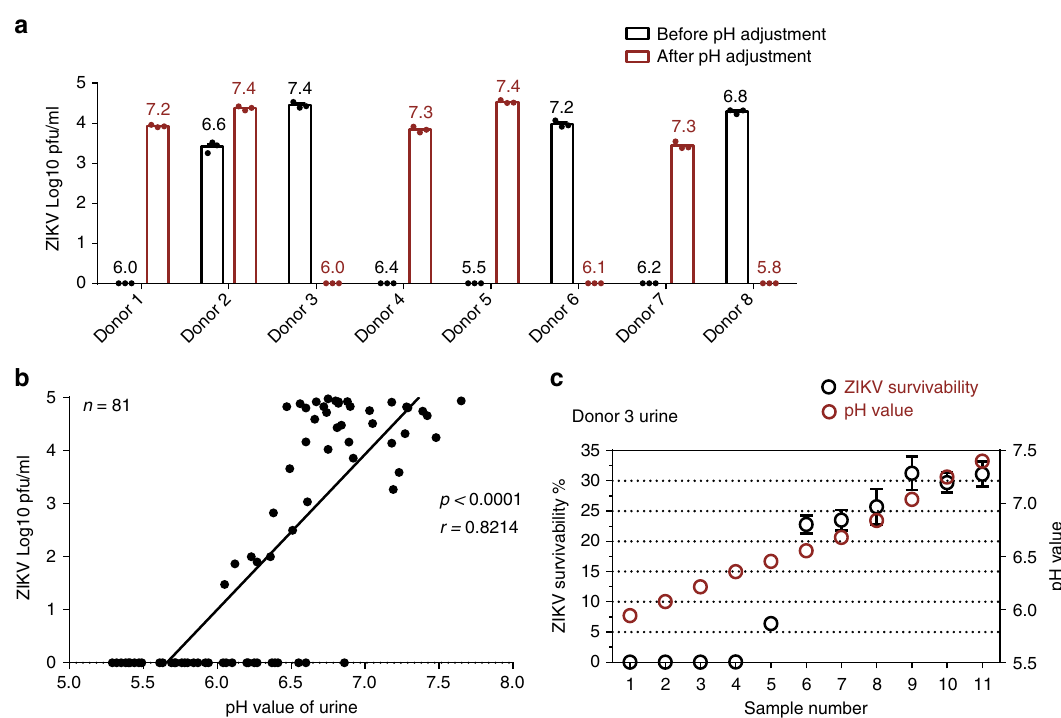
Fig. 4 Correlation between Zika virus (ZIKV) survivability and the pH value of human urine. a Adjustment of pH value regulated ZIKV survivability in human urine. The pH values of human urine samples were adjusted by either NaOH or HCl. The pH value is showed at the top of each column. n = 3 biologically independent samples. Data are presented as the mean ± SEM. b ZIKV survivability in human urine correlates with the pH value of urine. One dot represents one human urine sample. Data were analyzed by linear regression with correlation coef fi cients ( r ) and signi fi cance ( p ). n represents the number of human urine samples. The information for the urine samples is summarized in Supplementary Table 4. c Determination of the correlation between ZIKV survivability and the pH value in human urine. The urine samples from Donor 3 with gradient pH values were incubated with ZIKV supernatant. The percentage of ZIKV survivability was de fi ned as the ratio of the pfu value at 4 h incubation to the value at 0 h incubation. n = 3 biologically independent samples. Data are presented as the mean ± SEM. a – c The urine samples were incubated with ZIKV supernatant from infected Vero cells (the initial titer was 1 × 10 5 pfu/ml) for 4 h at 37 °C. Subsequently, the ZIKV titer was measured by a plaque assay. Source data are provided as